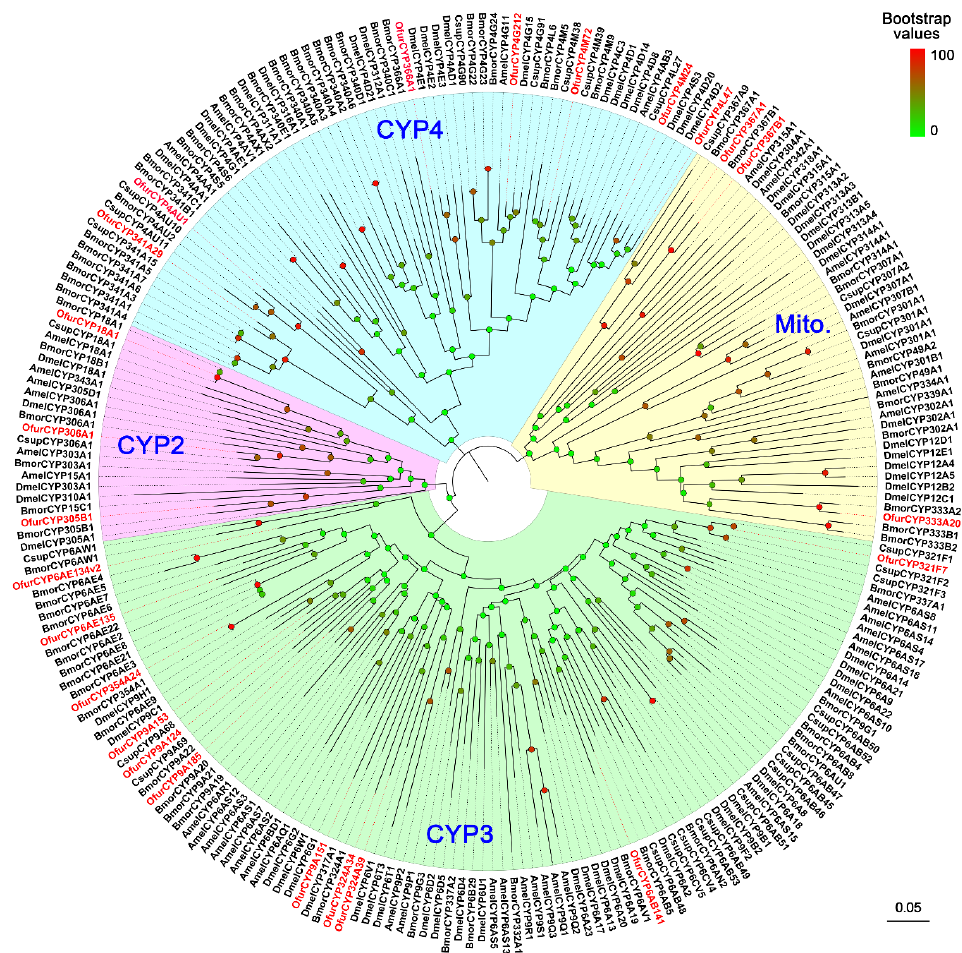
Figure 4. Phylogenetic analysis of CYPs from Ostrinia furnacalis (Ofur-prefix), Drosophila melanogaster (Dmel), Apis mellifera (Amel), Bombyx mori (Bmor), and Chilo suppressalis (Csup). Bootstrap values are indicated by coloring from green (0) to red (100) on each node. Insect CYPs are classified into four major clans (CYP2, CYP3, CYP4, and mitochondrial). The O. furnacalis CYPs are colored red. CYP sequences used in this analysis are listed in Table S1.